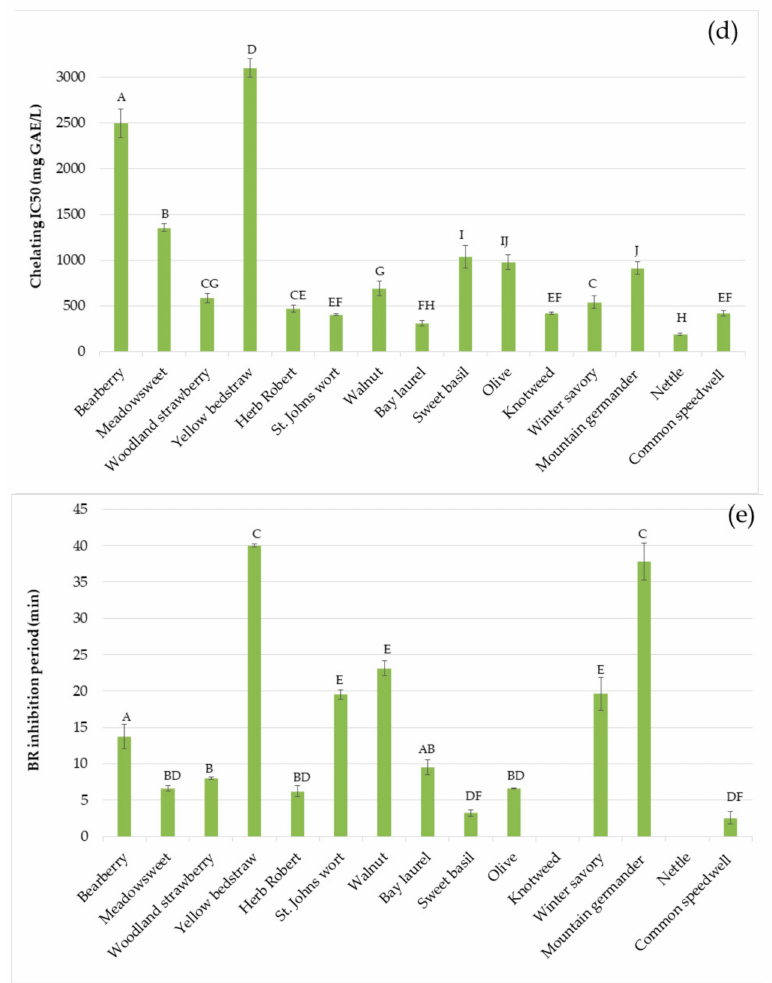
Figure 1. Antioxidant activity of plant extracts evaluated by ( a ) Ferric reducing antioxidant Power assay (FRAP), as scavenging activity against two free radicals: ( b ) 2,2-diphenyl-1-picril-hydrazyl (DPPH), ( c ) 2,2 (cid:48) -azinobis-(3-ethylbenzothiazoline-6-sulfonic acid) radical cation (ABTS), ( d )